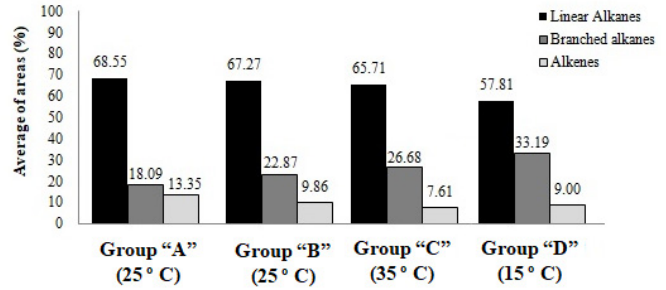
Fig 4. Abundance of compounds of each class present in the cuticles of Odontomachus brunneus workers submitted to different